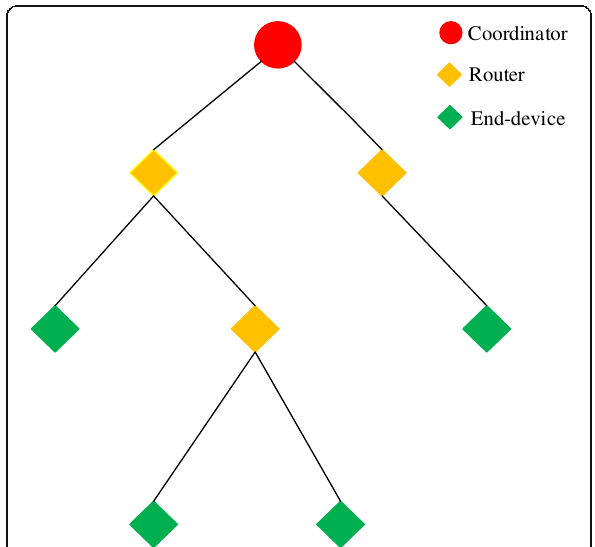
Fig. 1 Cluster tree topology of WSNs. This figure shows the simple and typical cluster tree network topology for wireless sensor networks